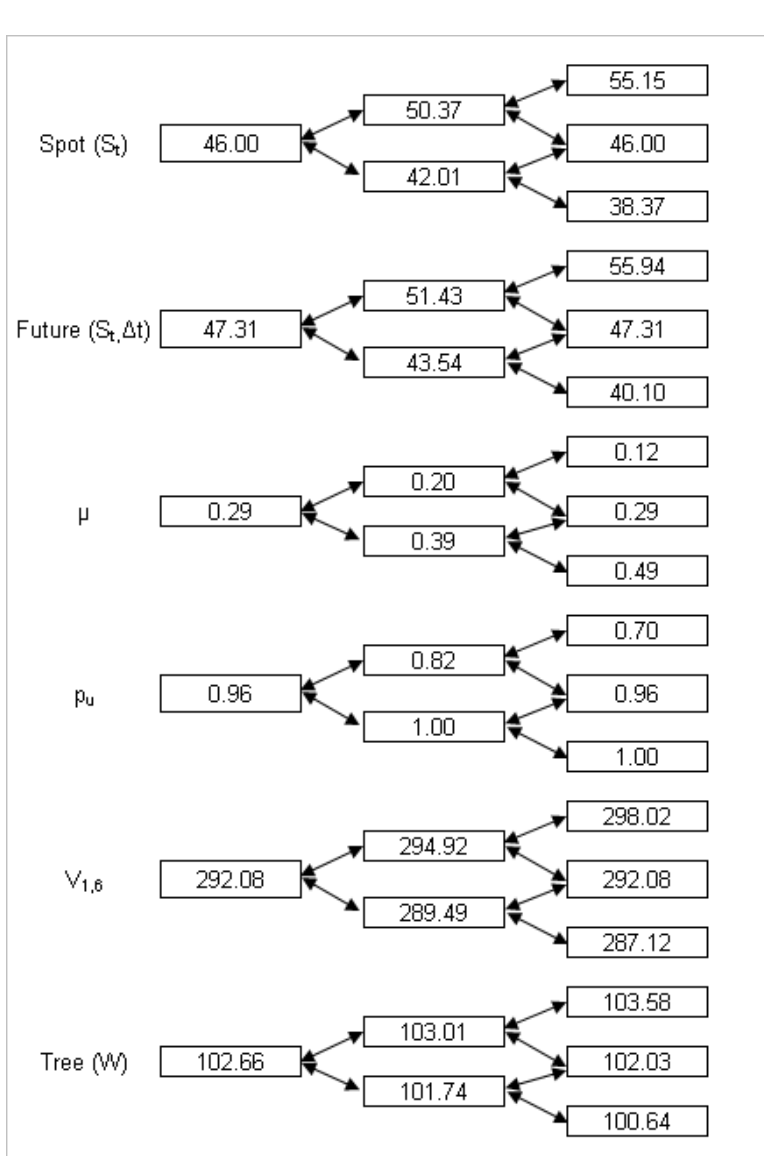
Figure 7. Computation by a binomial